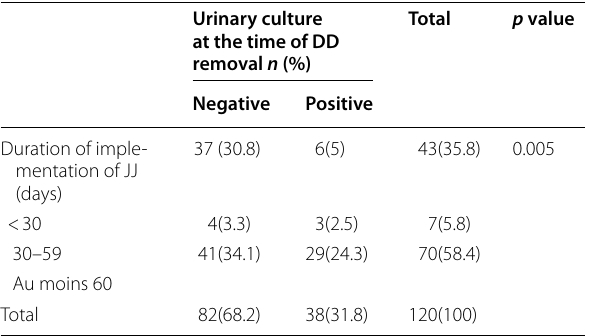
Table 3 Relation between the culture of the double J stent and the time of indwelling Culture of the double J n